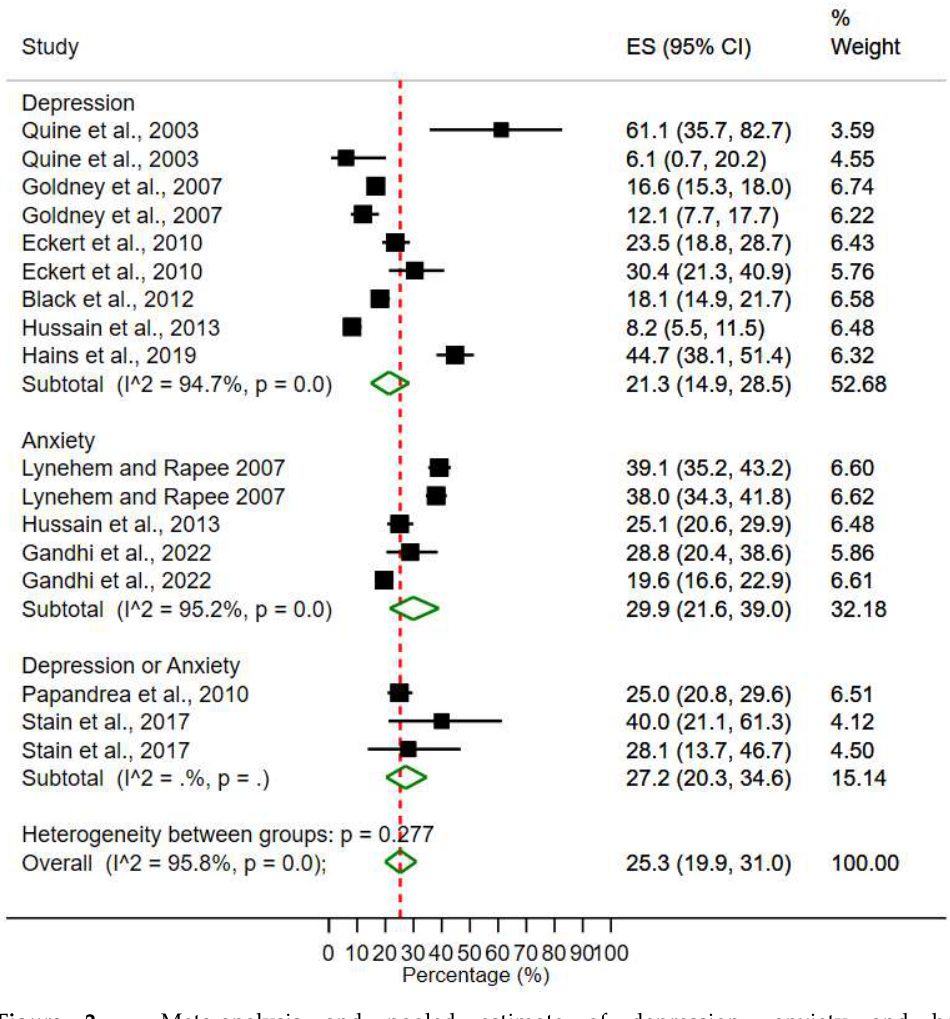
Figure 2. Meta-analysis and pooled estimate of depression, anxiety and both disorders.